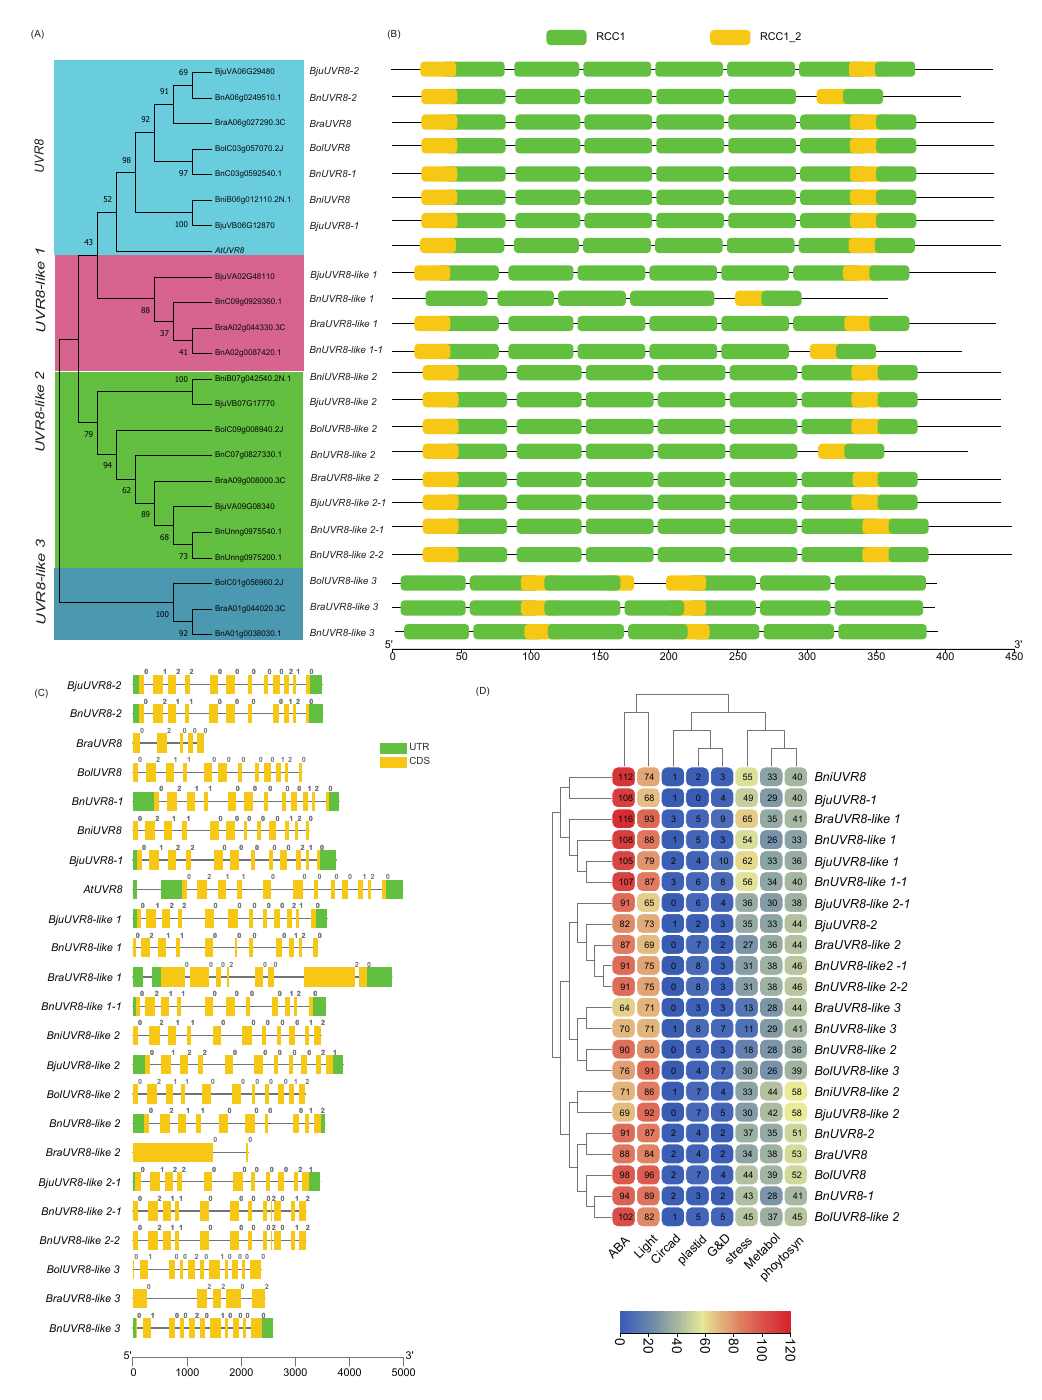
Figure 4. Phylogenetic analysis, classification, and structural description of UV-resistance locus 8 (UVR8) gene family in Brassica species. ( A ) The unrooted phylogenetic tree was established with Ara- bidopsis and five Brassica species ( B. rapa , B. oleracea , B. nigra , B. napus , and B. juncea ) UVR8 protein sequences using the neighbor-joining tree method with 1500 bootstrap replications in MEGA11. ( B ) Represents the domain architecture of phylogenetically classified UVR8 genes of Brassica species, while ( C ) represents the gene structures including Intron/exon pattern and intron phases (Class 0, 1, and 2) and UTRs. ( D ) Heatmap represents the key cis-regulatory elements (ABA- and light- responsive, elements associated with plastids, circadian rhythm, growth and development (G&D), stress, metabolite biosynthesis, and photosynthesis) and their abundance in putative promoter motifs of Brassica UVR8 genes reported in this